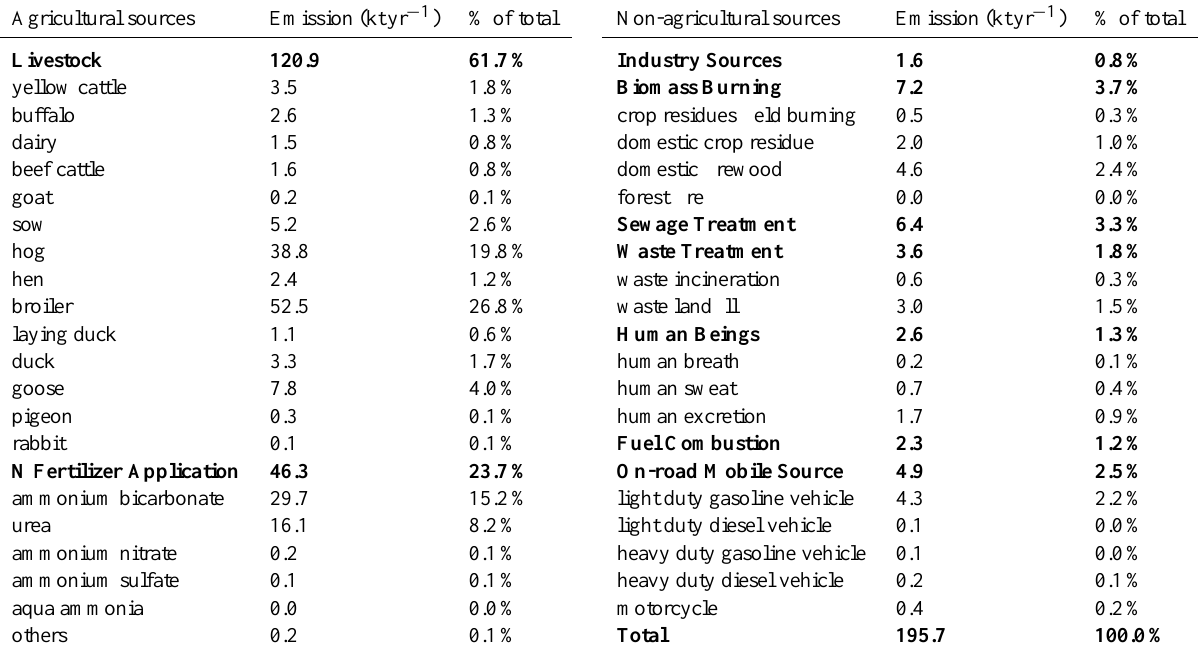
Table 4. NH 3 emission inventory in the PRD region,